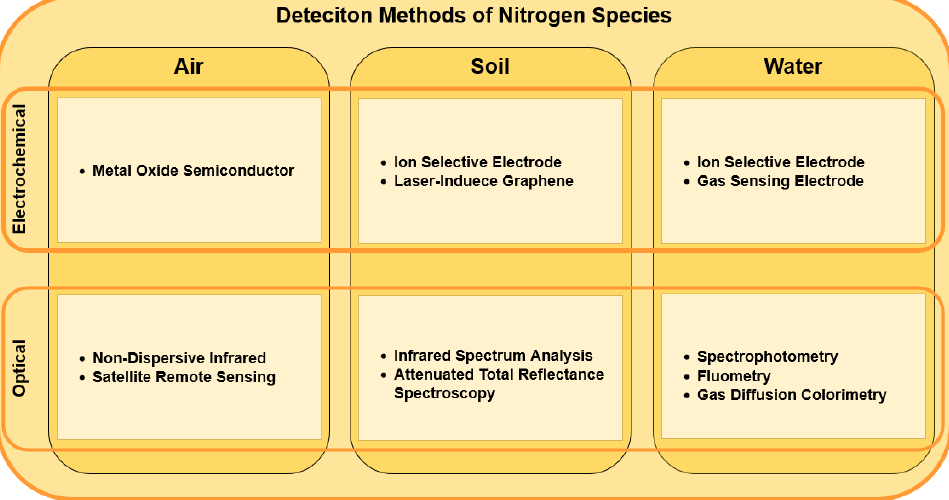
Figure 1. Deteciton methods of nitrogen